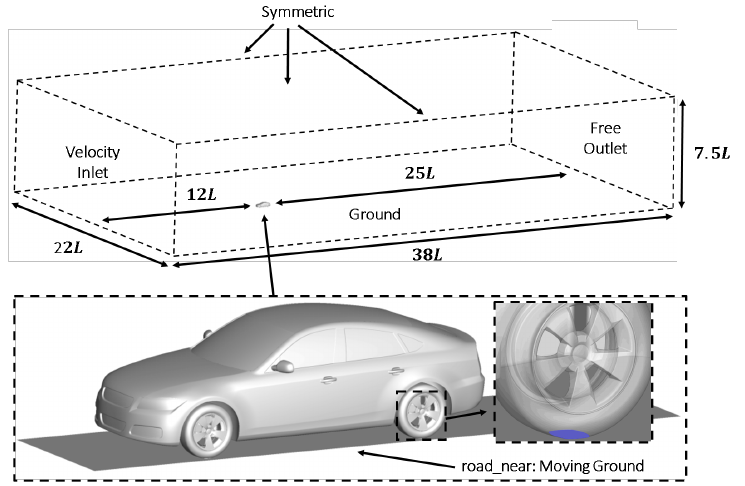
Figure 2. Computational domain with closeup of moving ground plane (in gray) and morphed tire geometry (in blue) for the rotating wheels